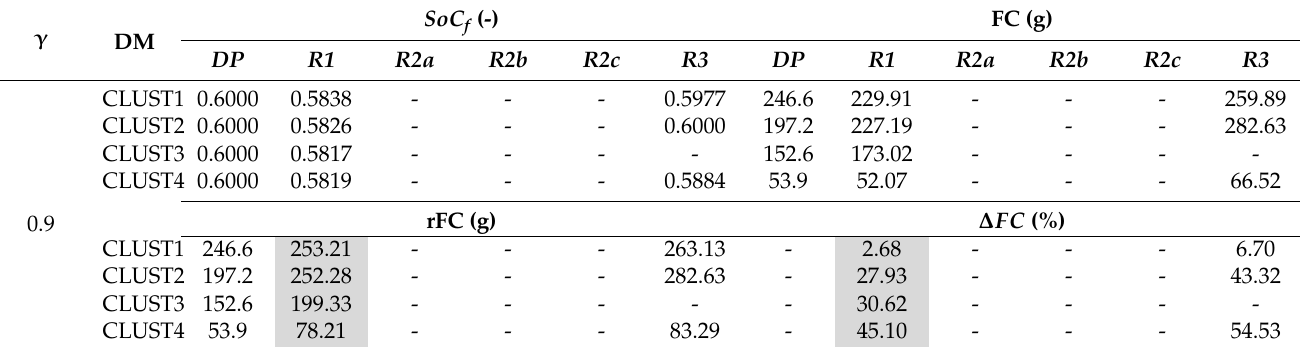
Table 3. Reward shaping analysis considering γ = 0.9.